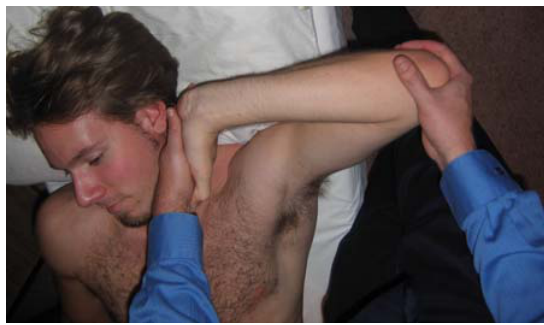
FIGURE 4. Neural tension manipulation of ulnar nerve.